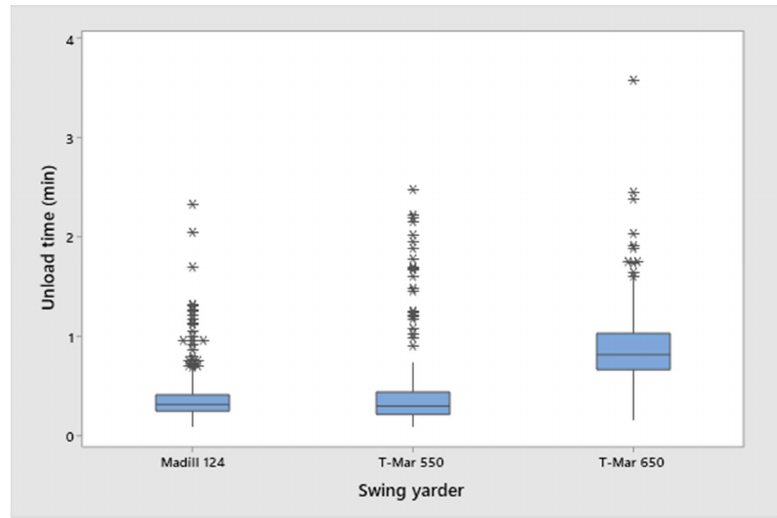
Figure 5. Boxplot showing variability in unhook time across the swing yarders studied. * represent the plot of unhook time (min) on the y-axis for each swing yarder.